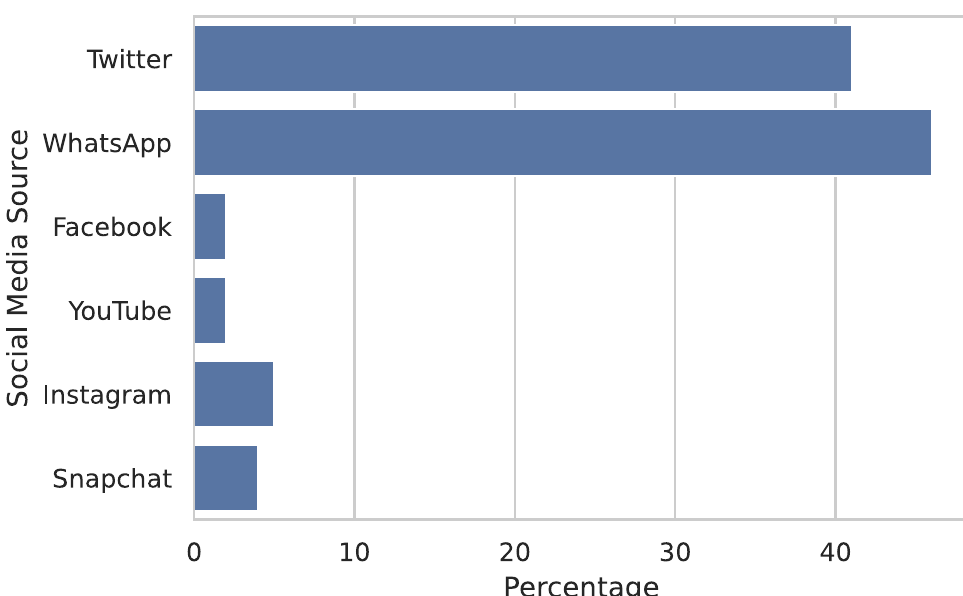
Figure 5. Social Media Sources of Misinformation Reported by the Community.